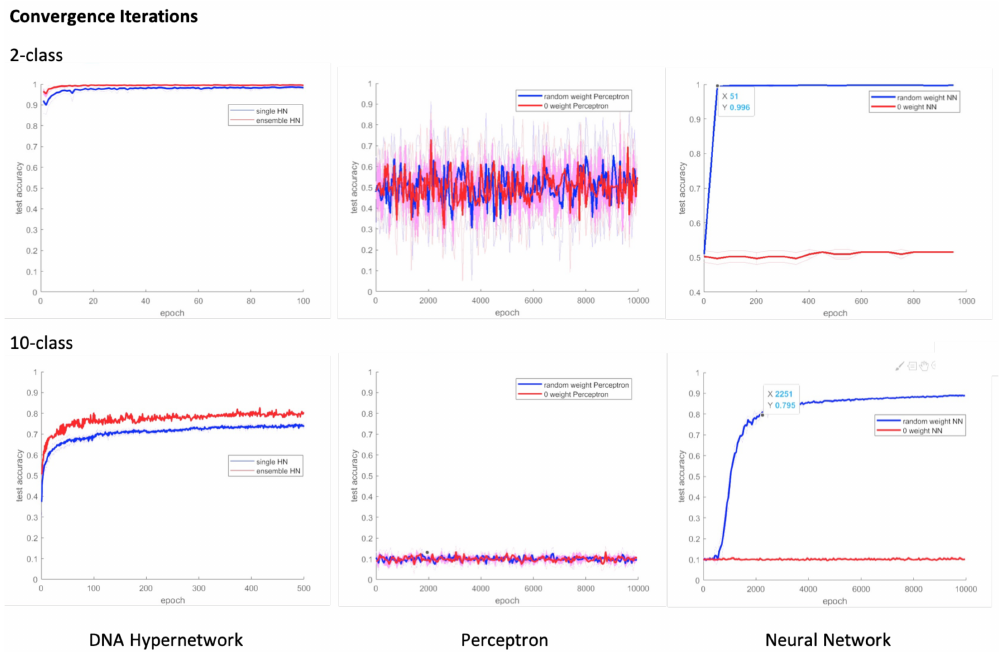
Figure 9. In silico experimental results. Computer simulation of 10-class classification with